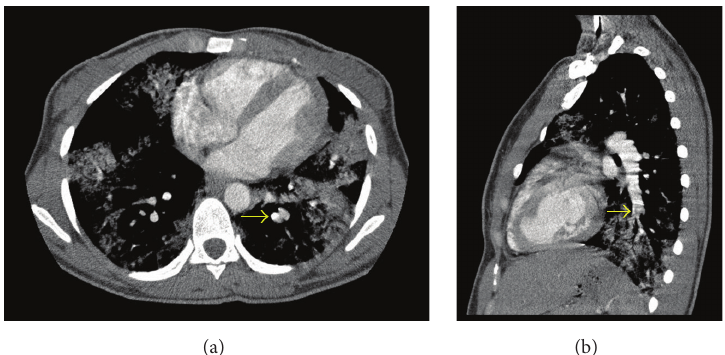
Figure 1: Volumetric computed tomography acquisition of the chest from the thoracic inlet to the upper abdomen, following 65 mL of intravenous contrast (Omnipaque 300) employing pulmonary embolism protocol. A filling defect has been demonstrated in the left lower lobe segmental pulmonary artery (arrows: (a) axial; (b)